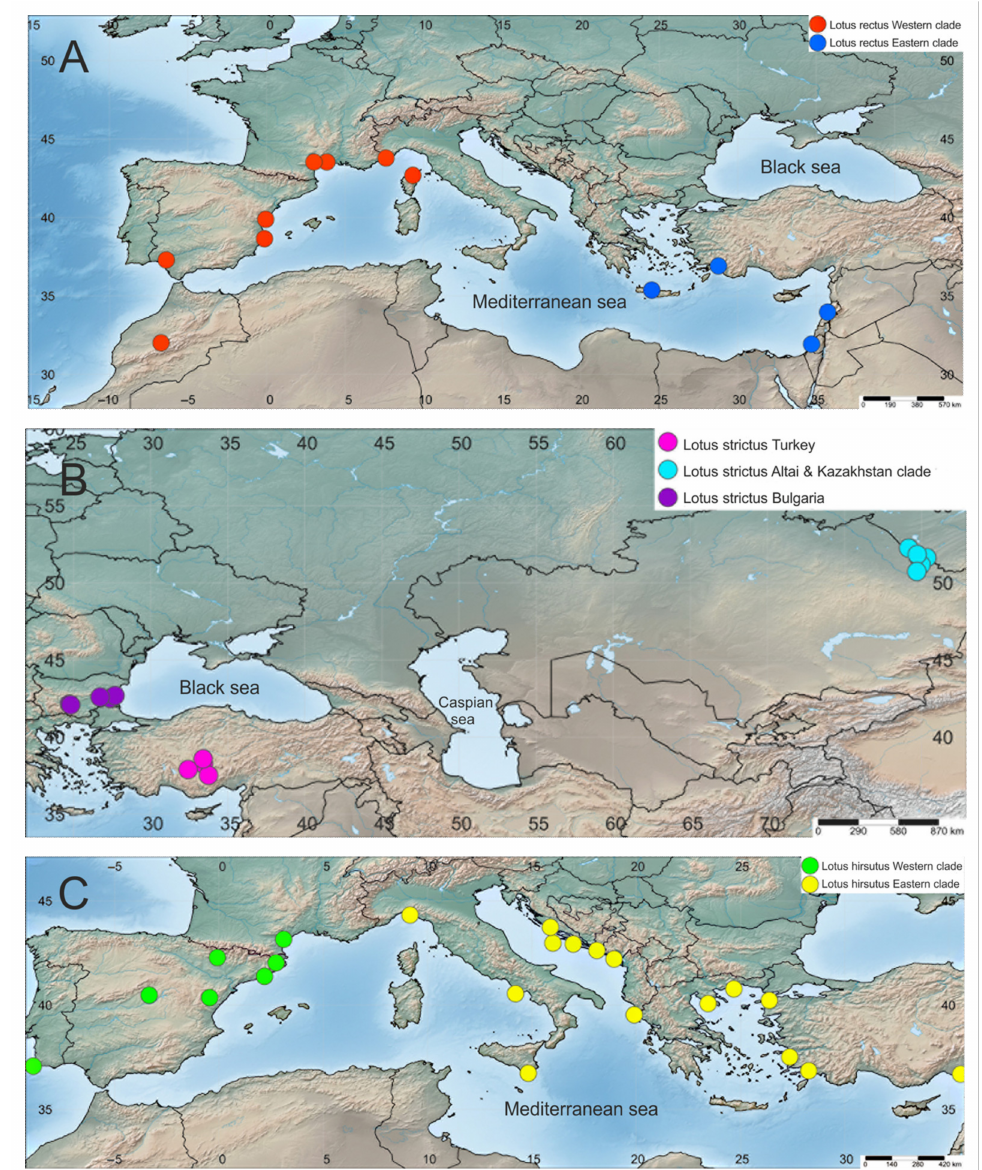
Figure 2. Geographical distribution of clades revealed in nrITS phylogenetic analysis of species: ( A )— L. rectus , ( B )— L. strictus , ( C )— L. hirsutus